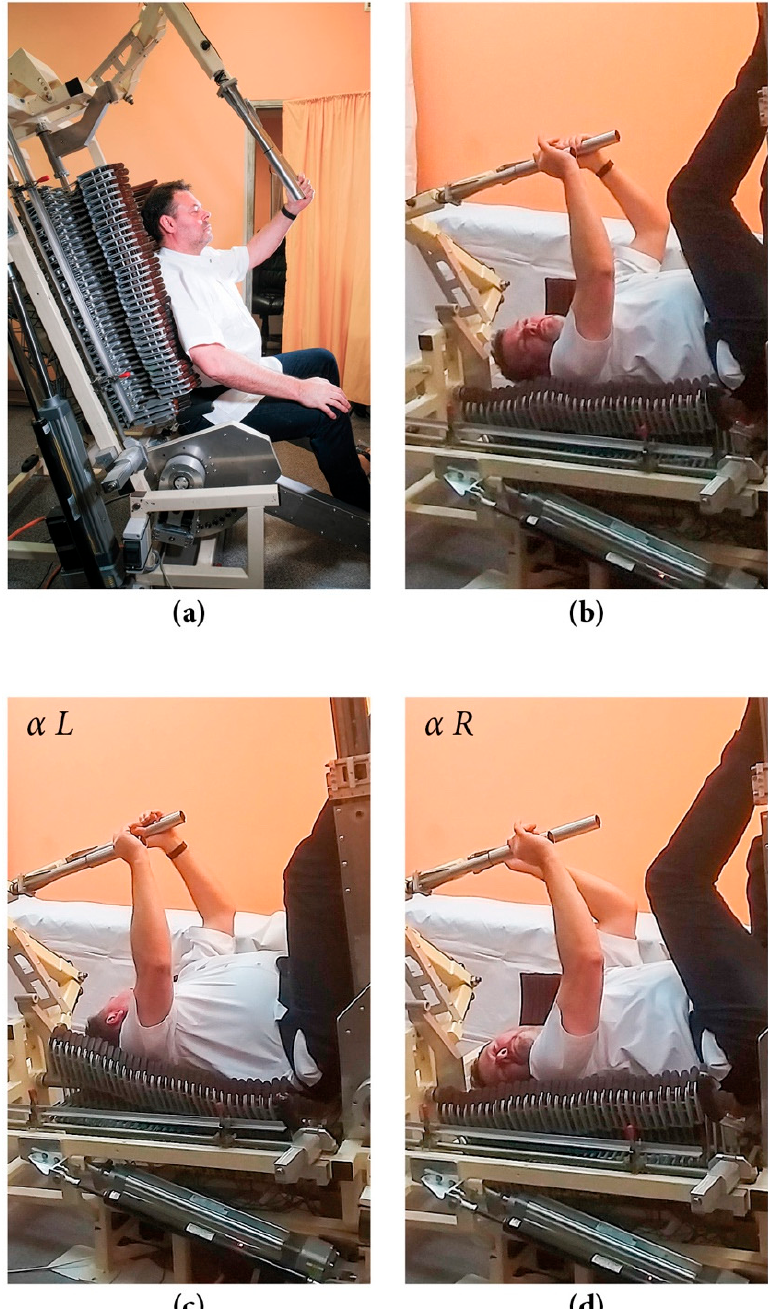
Figure 5. Dynamic spine correction (DSC) device positions. ( a ) Starting. the patient sits on the device in a vertical position and leans his back against the segments, which adjust to the spinal curvatures and support its entire length, while the safety belt at the level of the anterior superior iliac spines (ASIS) ensures the proper position of the patient. ( b ) Working–neutral: patient moves to the horizontal position, their hands and legs are placed on resistance handles, and they exercise in weak gravitational traction, resulting from a slanted positioning of the long axis of their trunk relative to the ground. ( c ) Rotation to the left ( α L). ( d ) Rotation to the right ( α R): the patient performs the exercise by alternately flexing and extending upper and lower limbs. The resistance handles allow the patient to perform torso rotational movements. In the long axis of the spine, the DSC has actuators that act as a spring and stretch the spine during the exercise. The α L and α R are measured by DSC sensors when the largest deviation is achieved from starting